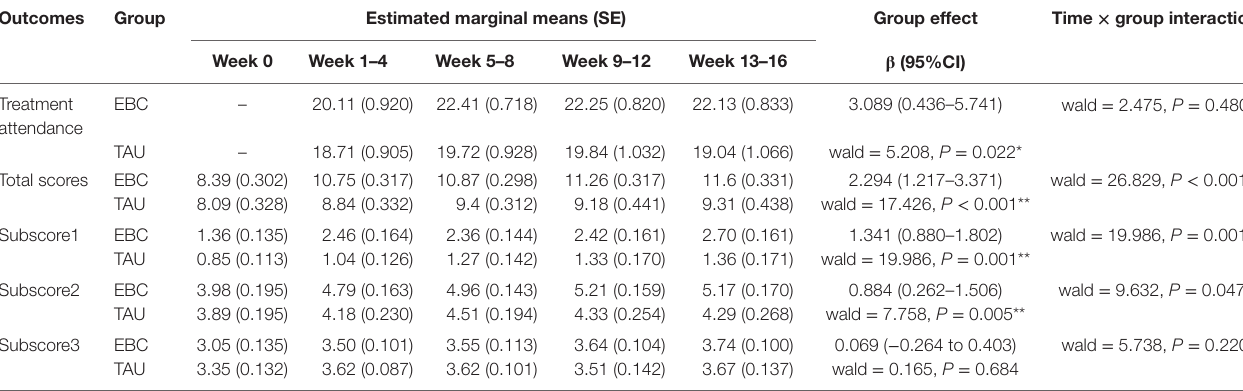
TaBlE 4 | Generalized estimating equation analyses for primary and secondary outcomes (continuous